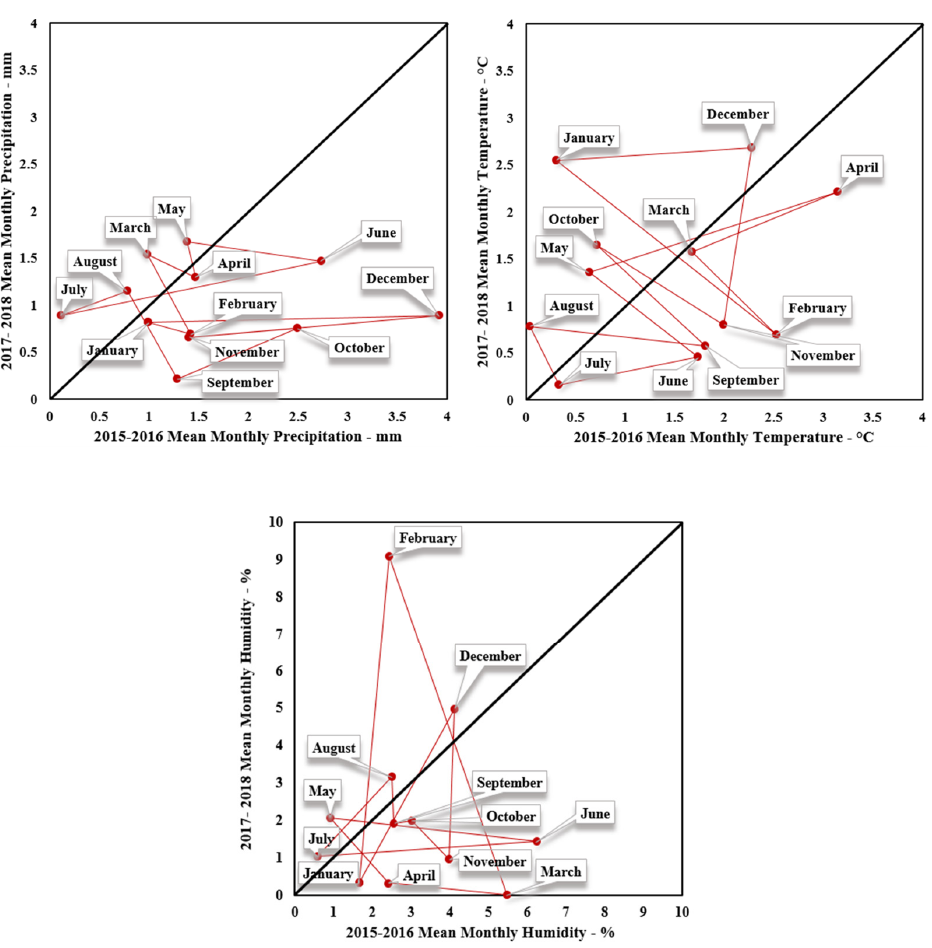
Figure 8. IPTA Method Graphs of Standard Deviation Analysis Results of Sakarya Province. Table 3. General Evaluation of Standard Deviation Analysis Results for Each Parameter.